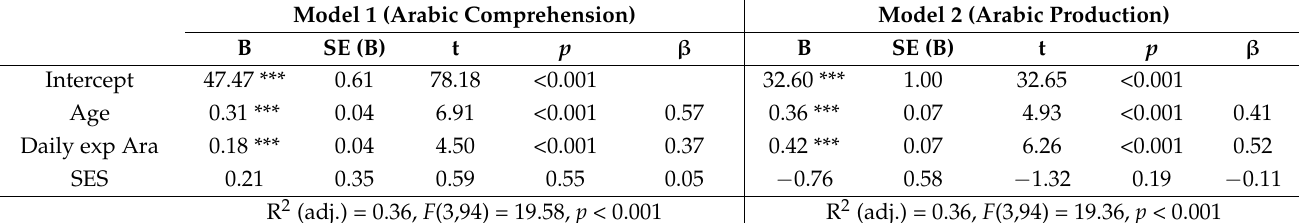
Table 4. Multivariate linear regression models for Arabic comprehension and Arabic